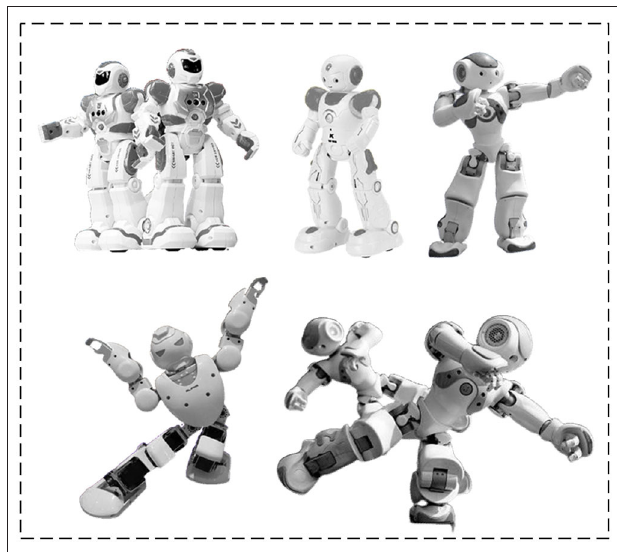
FIGURE 9 | Basic dance elements imitated on limb L 1 (head).